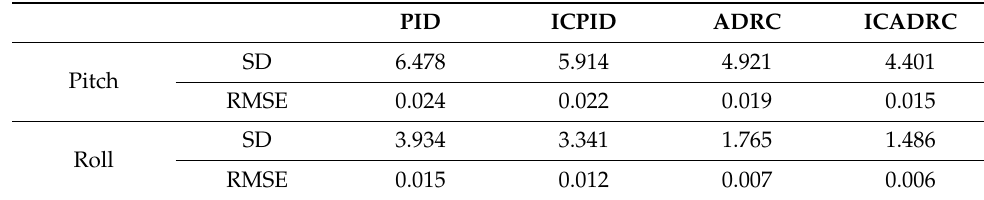
Table 5. Landing results on the sea.